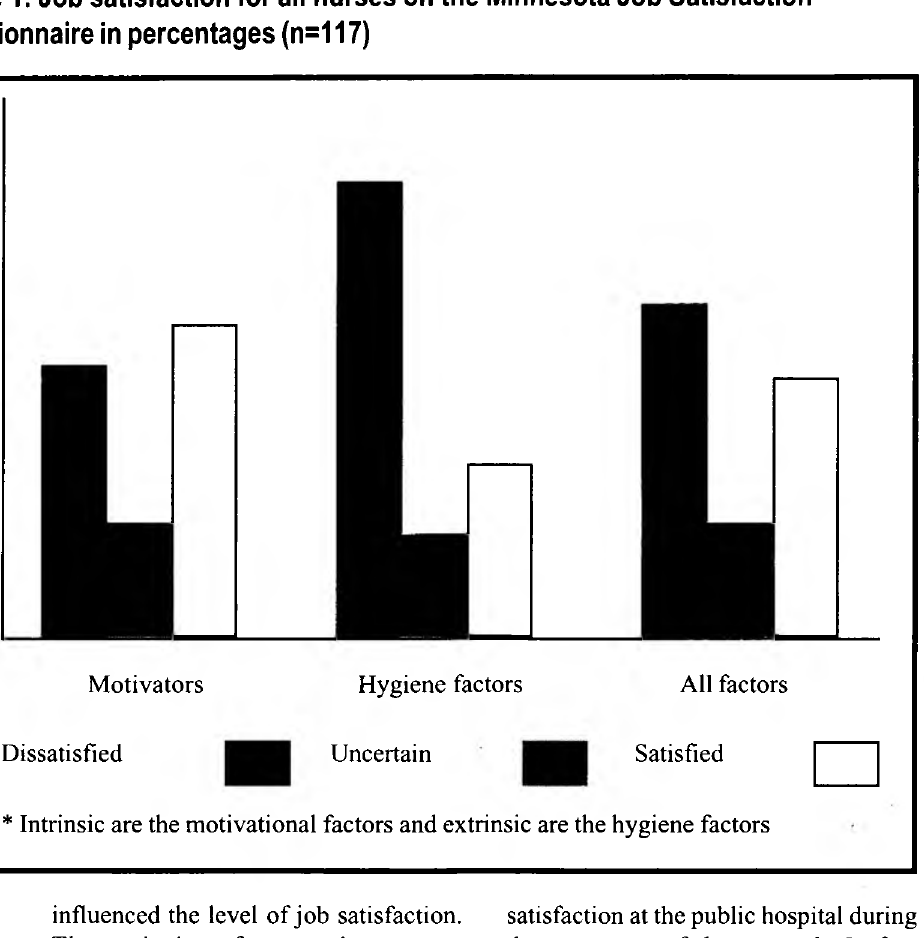
Figure 1: Job satisfaction for all nurses on the Minnesota Job Satisfaction